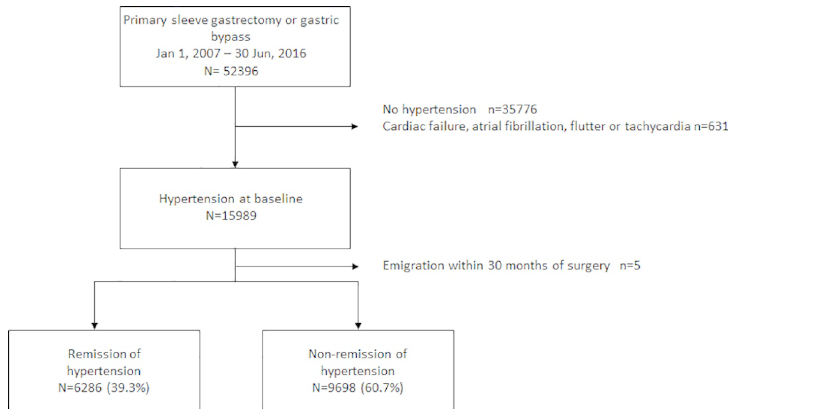
Fig 1. Flowchart describing participant’s identification and